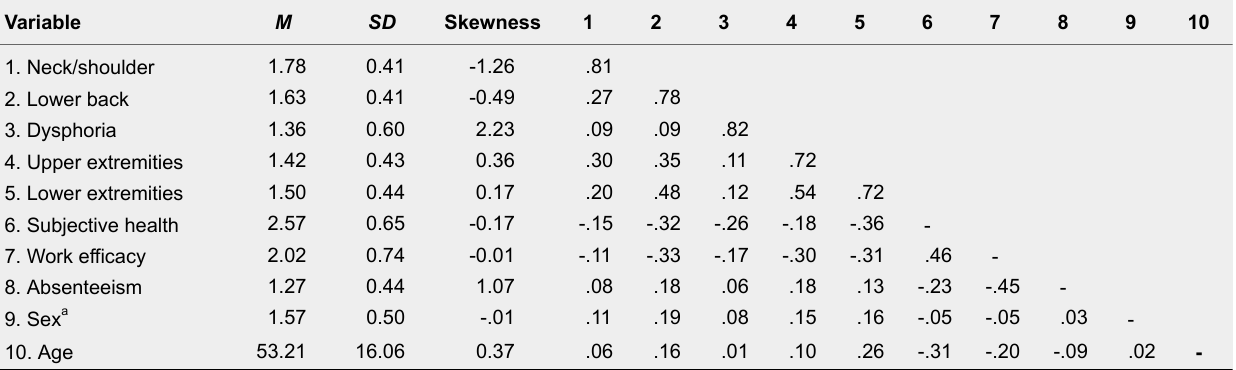
Means (M), Standard Deviations (SD) and Zero Order Correlations Among Variables Variable